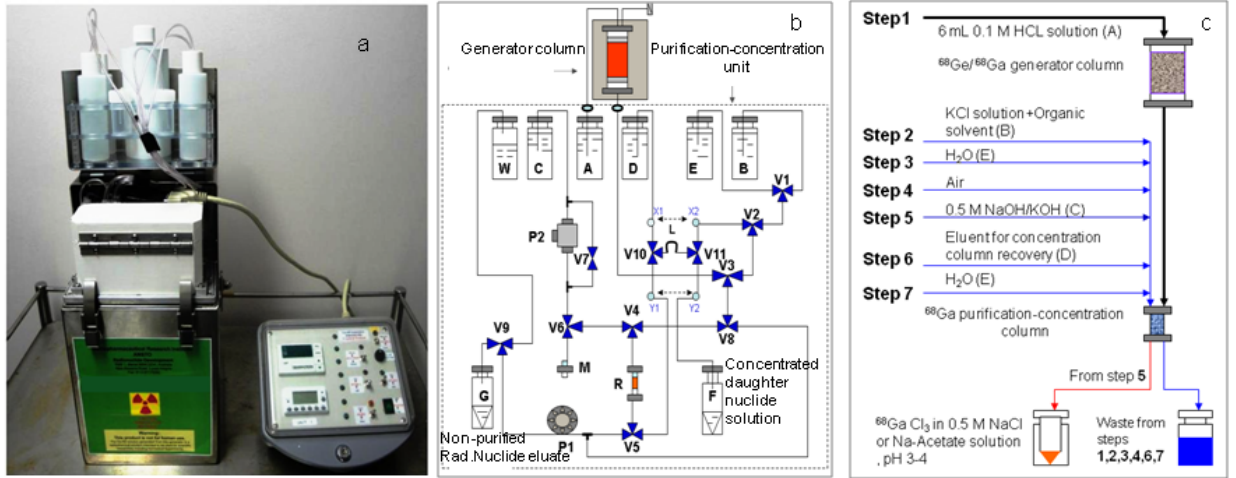
Figure 7. Automation process and Flow chart of the universal Radioisotope